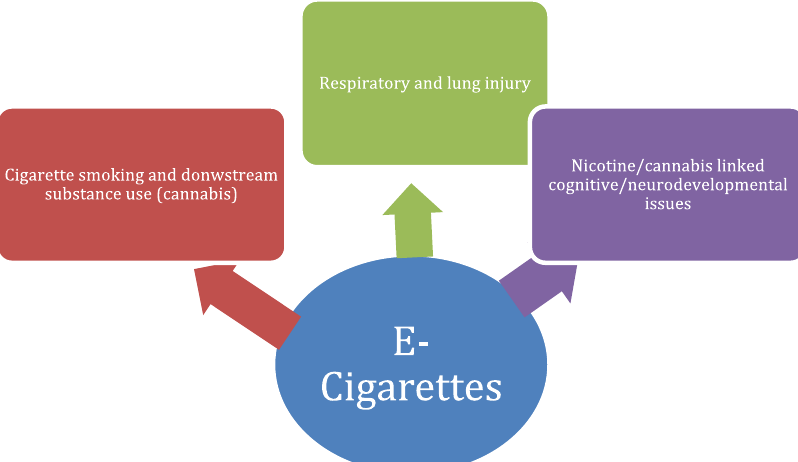
Fig. 4 The health risks associated with vaping 37,46 – 48,51,52,55 . The following fi gure illustrates the relationship between e-cigarette exposure and potential health effects in teenagers, which primarily affect the respiratory system, neurodevelopment/cognition, and may increase the risk of dual smoking and addiction to other